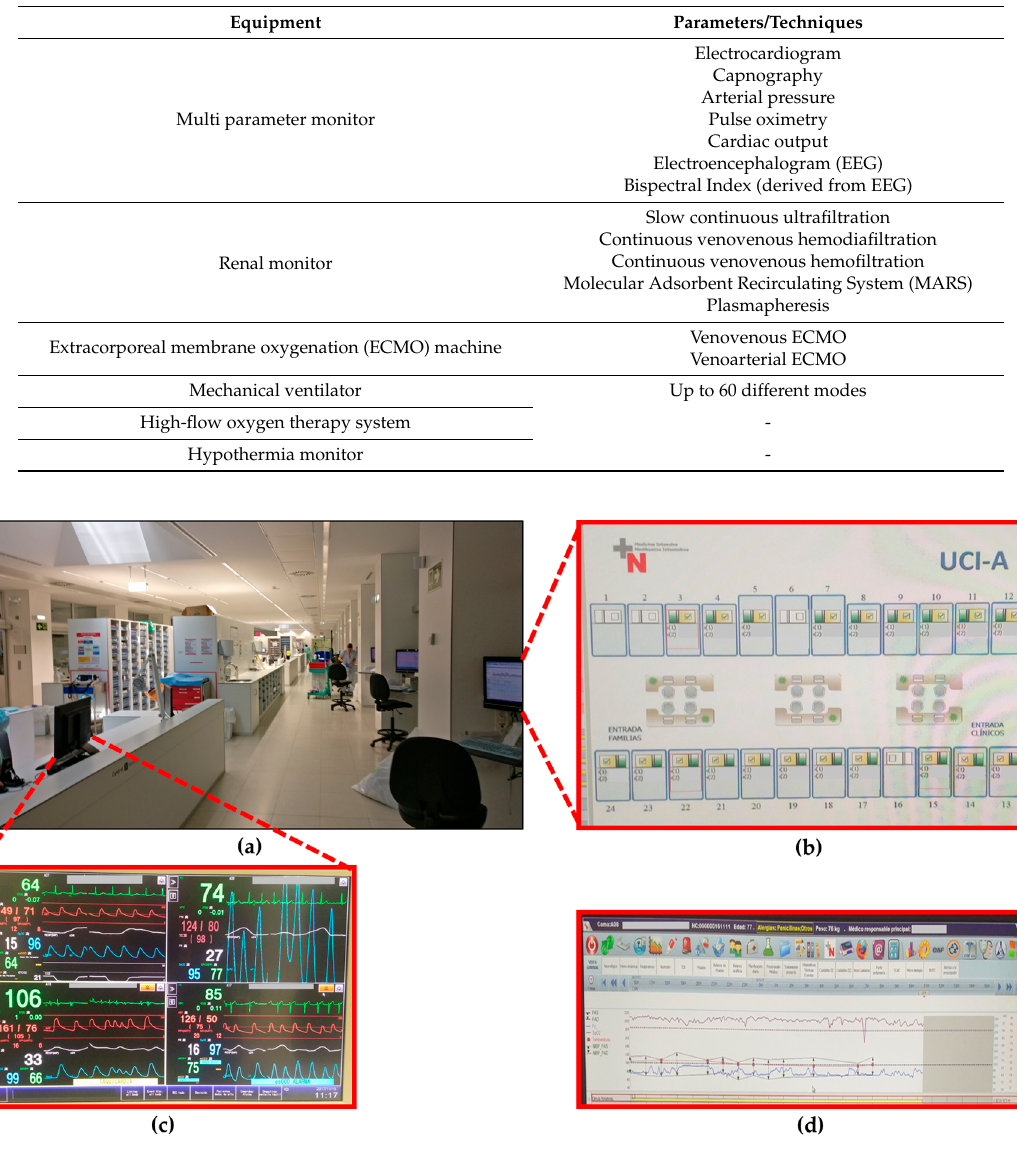
Table 1. Medical equipment included in a ward of the ICU of the Hospital Complex of Navarra.